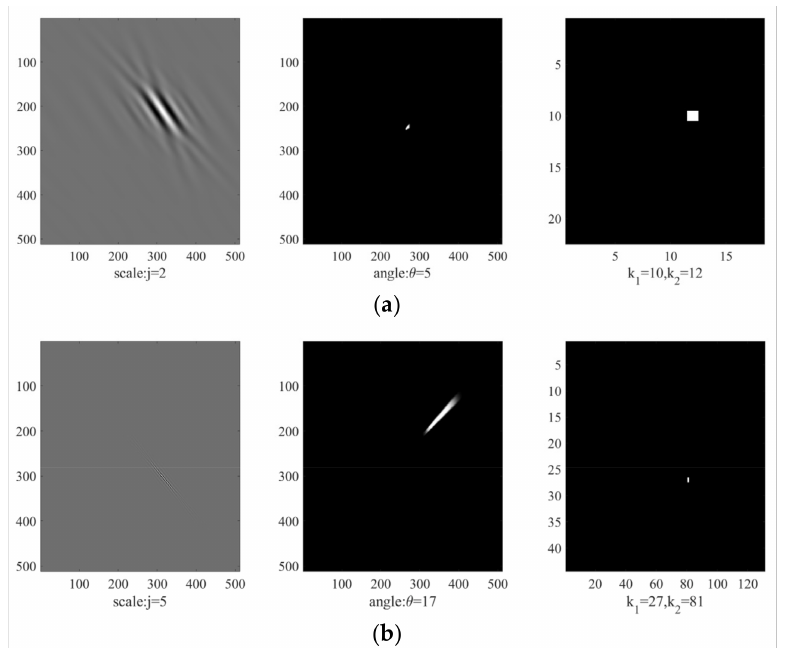
Figure 1. Diagram curvelet-based function. ( a ) The coarse scale. The left side represents the spatial scale viewpoint (j = 2), the middle represents the angle coefficient ( θ = 5) of the frequency components, and the right side is the curvelet coefficient ( k 1 = 10, k 2 = 12) viewpoint. ( b ) The fine scale. The left side represents the spatial scale viewpoint (j = 5), the middle represents the angle coefficient ( θ = 17) of the frequency components, and the right side is the curvelet coefficient ( k 1 = 27, k 2 = 81)